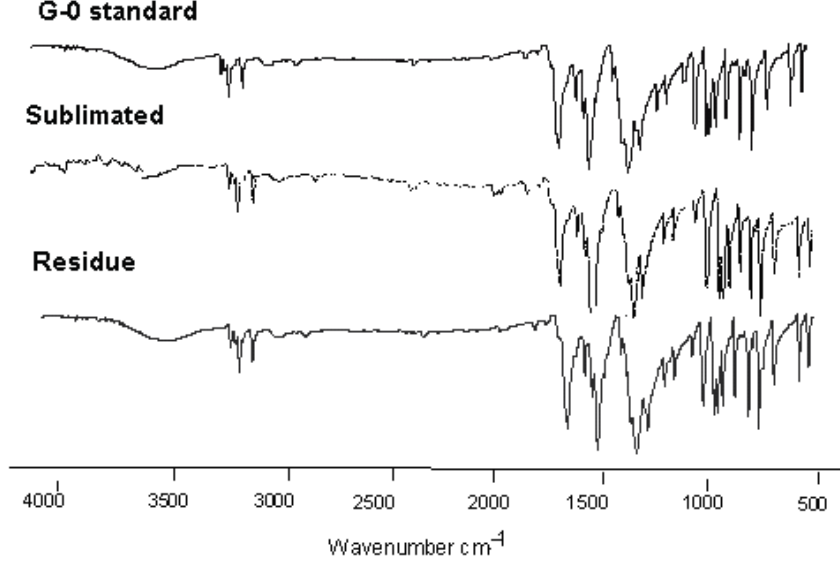
Figure 3. Fourier-transformed-infrared spectra ( FT-IR, transmission mode) of G-0 standard, sublimated product and residue.